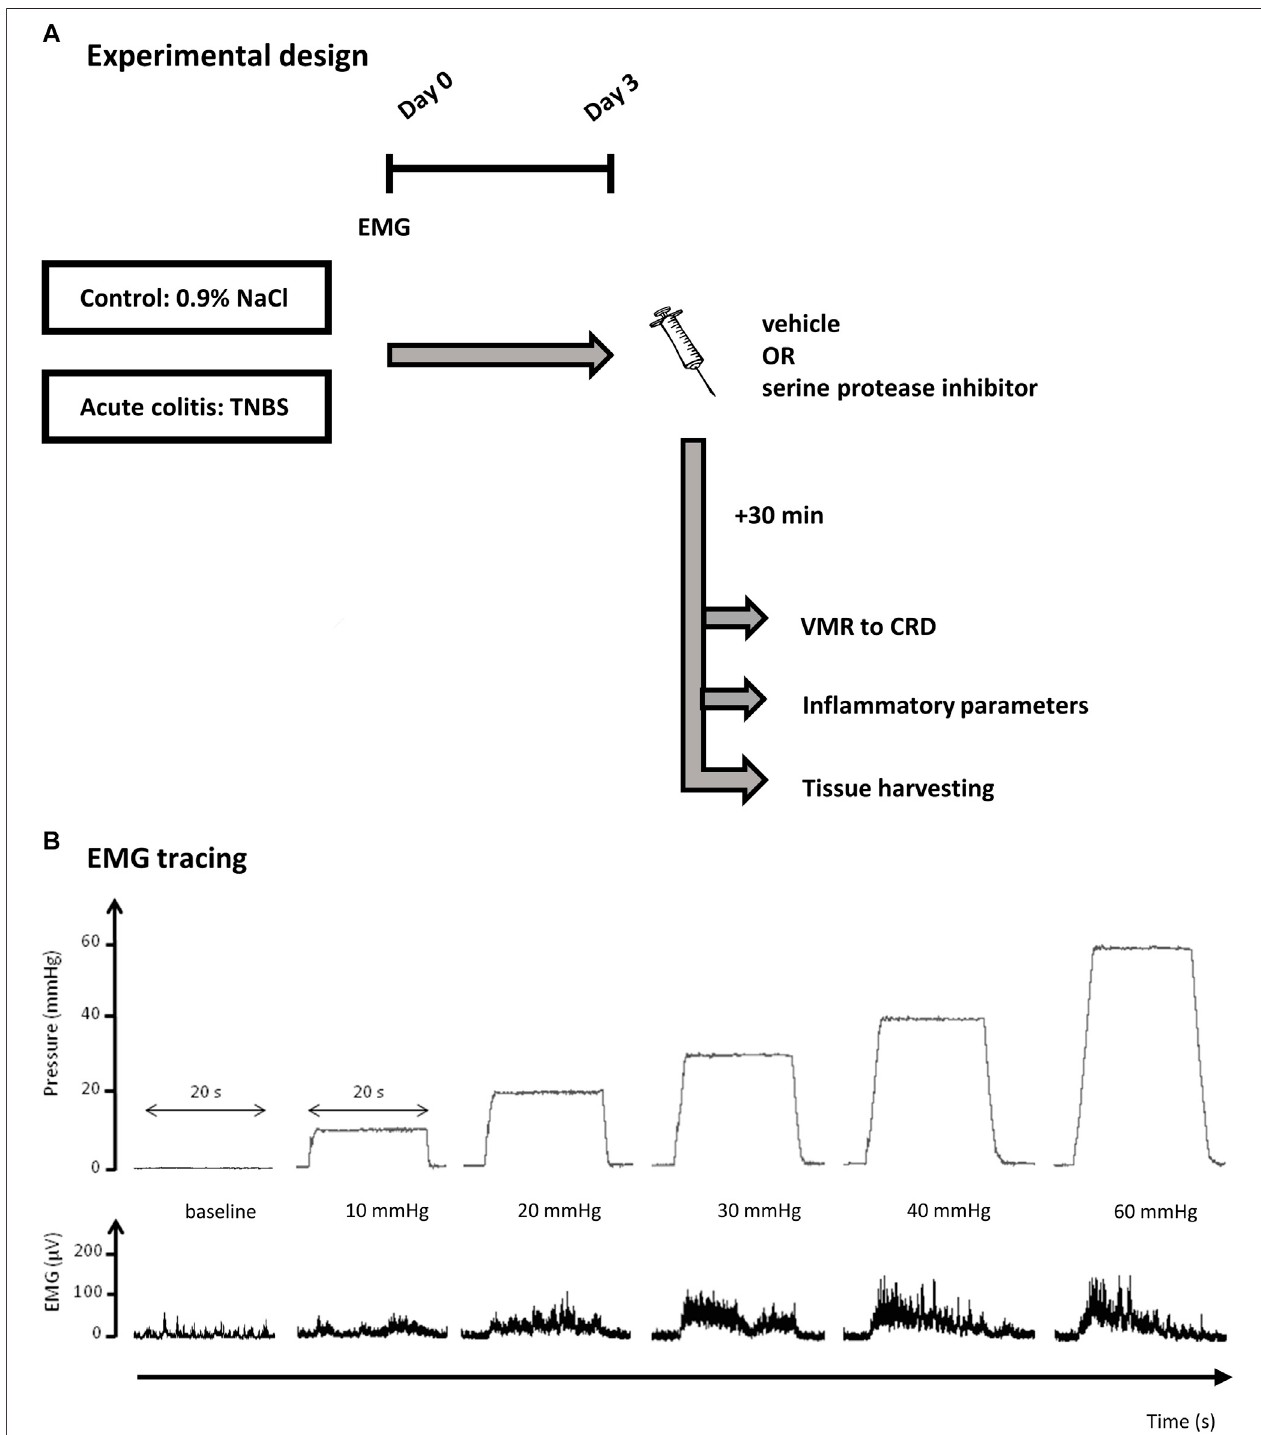
FIGURE1| TheeffectofUAMC-00050(0.1 – 1 mg/kg)anditsvehicle(5%DMSO)onVMRsinacutecolitisandcontrolrats. (A) Overviewoftheexperimentaldesign in acute TNBS-colitis rats. On day 0, rats had an intrarectal administration with TNBS (colitis) or saline (control) and the implantation of EMG electrodes. Further experiments were conducted at day 3. A compound (nafamostat or UAMC-00050) or vehicle (5% DMSO) was injected i. p. 30 min prior to the VMR experiment. Afterwards, the in fl ammatory status was determined and tissues were harvested for further experiments. CRD: colorectal distension; EMG; electromyographic;